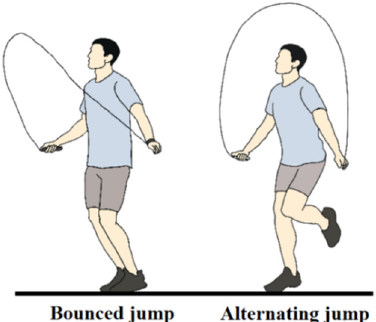
Figure 2. A diagram of bounced jump (BJ) and alternating jump (AJ).